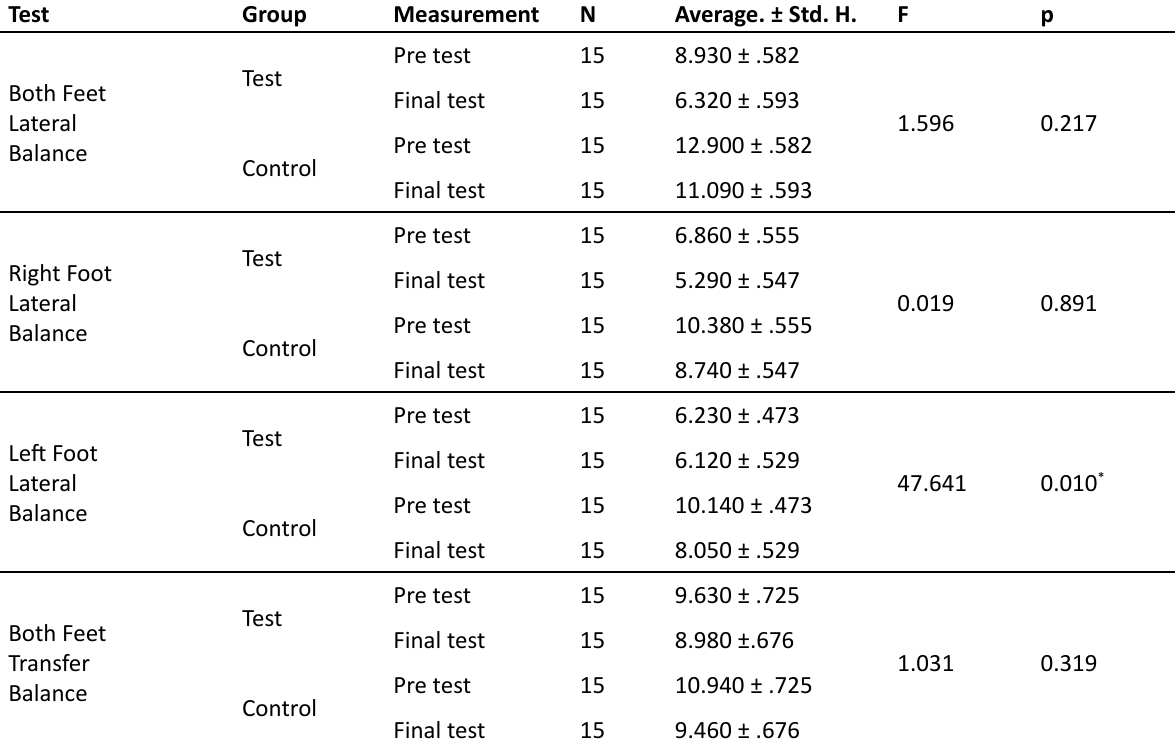
Table 8. Group x time interaction according to balance test values Test